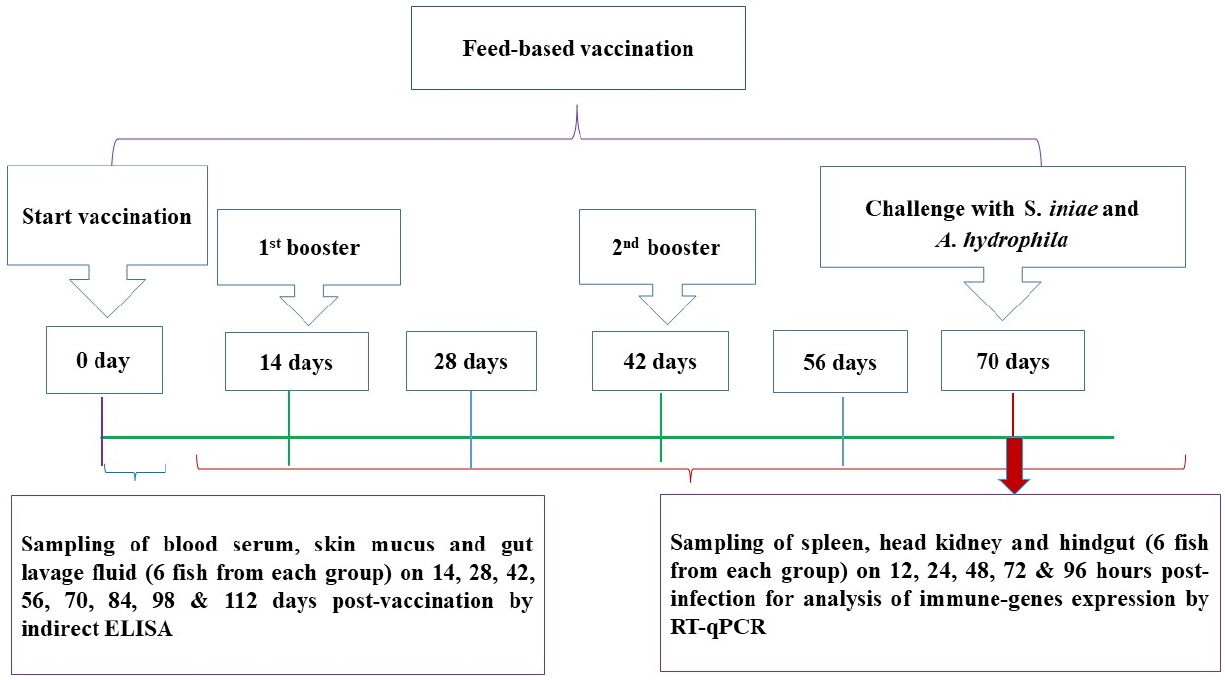
Figure 1. Timeline of the feed-based vaccination regime and challenge assays in red hybrid tilapia.